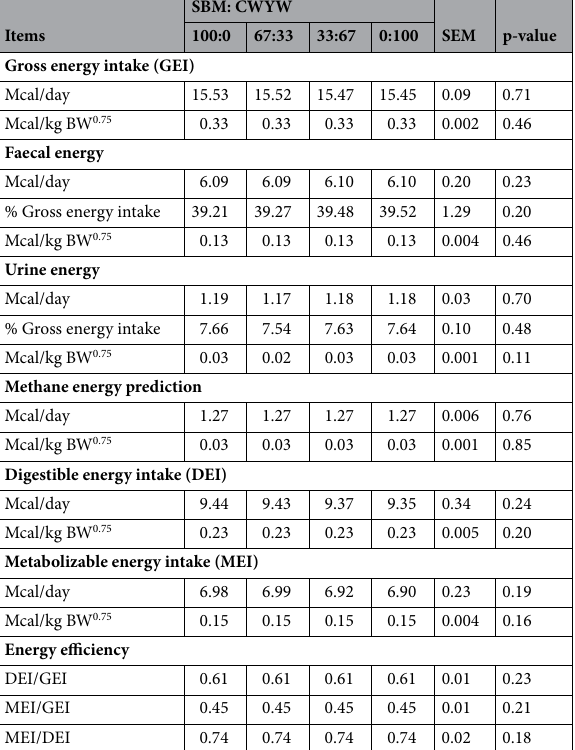
Table 5. Effect of replacing soybean meal with citric waste fermented yeast waste on energy utilization and efficiency in Thai-native cattle. SEM standard error of the mean, SBM: CWYW replacing soybean meal with citric waste fermented yeast waste